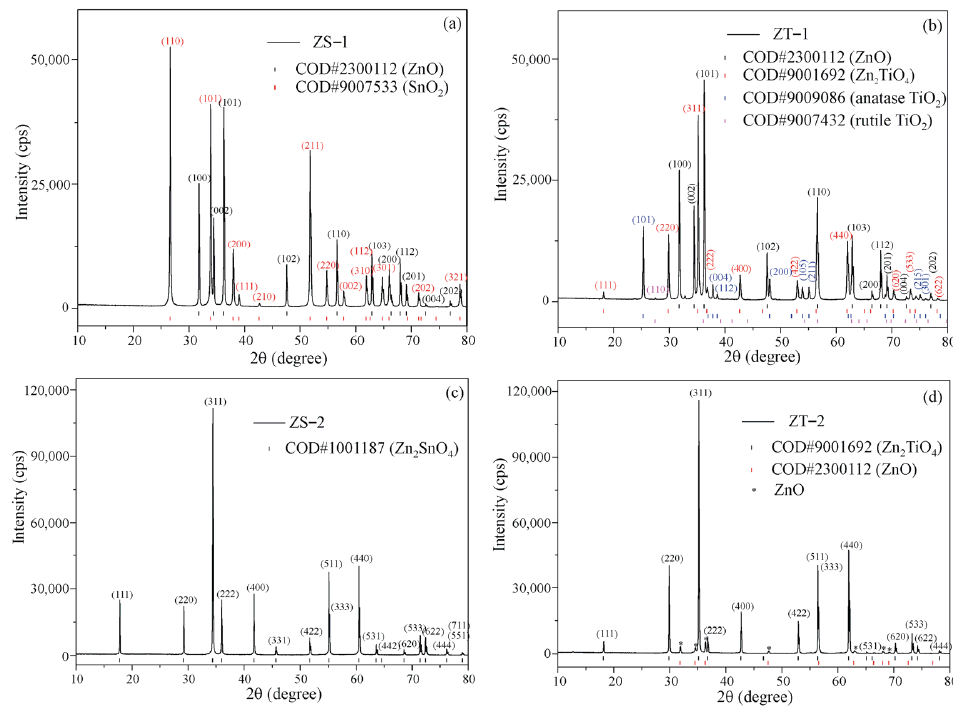
Figure 3. XRD patterns of ( a ) ZS–1, ( b ) ZT–1, ( c ) ZS–2, and ( d ) ZT–2 catalysts. Table 1. Phase composition and structure parameters of ZS–1 by Rietveld refinement.